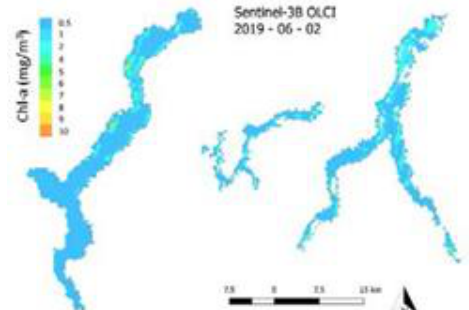
Figure 5. Maps of concentration of Chlorophyll-a obtained with Sentinel-3B imagery (2 June